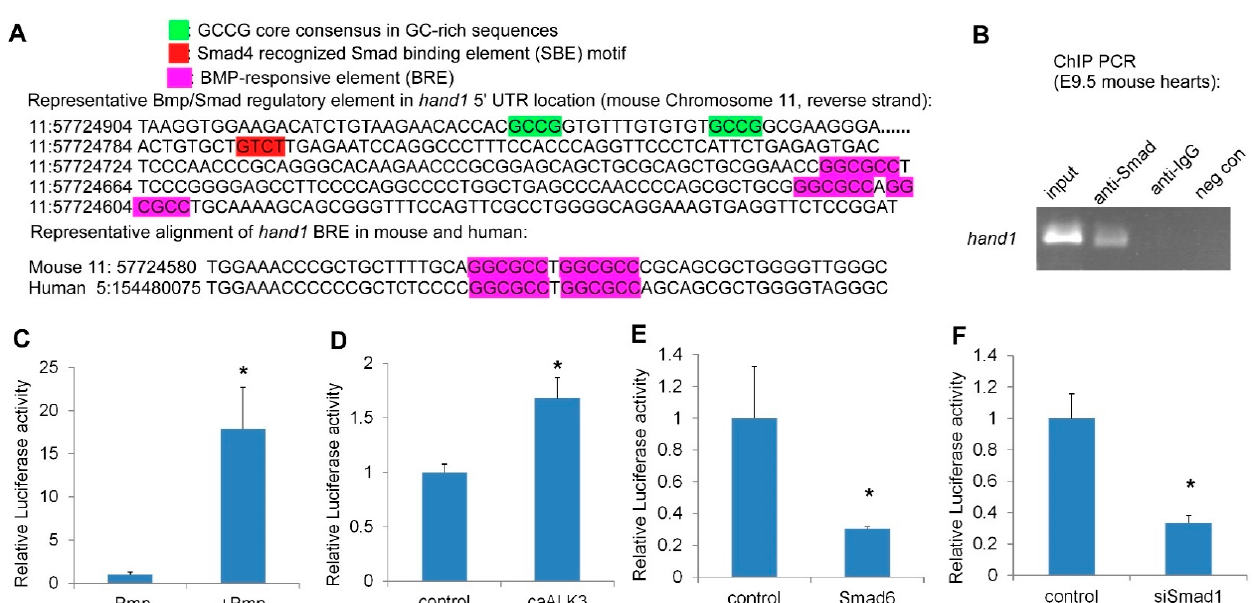
Figure 3. Hand1 is a direct target activated by the canonical Bmp/Smad signaling. ( A ) Representative Bmp/Smad regulatory element in Hand1 5 ′ UTR location (at upper) and sequence alignment (at lower), showing the conservation among mouse and human (source: Ensembl). ( B ) In vivo ChIP PCR using E9.5 hearts with indicated antibodies to IP chromatin fragment. PCR band (size: 215bp) contains the Hand 1 5 ′ UTR Bmp/Smad regulatory element. ( C - F ) Hand1 5 ′ UTR reporter luciferase assays: treated with Bmp ( C ), co-transfected with constitutively active ALK3 (caALK3) ( D ), pcDNA3.1- Smad6 ( E ), and pSR si Smad1 ( F ). Data are presented as means ± s.e.m. * indicates p -value < 0.05.